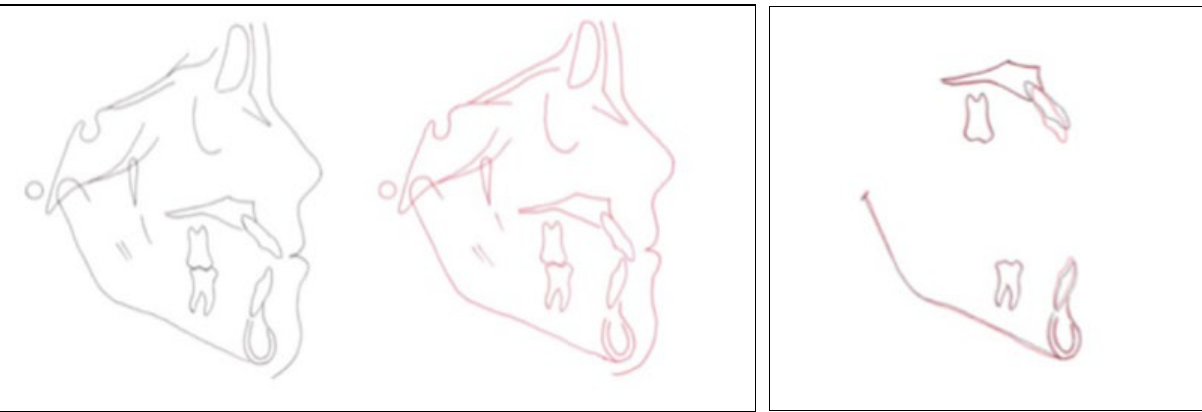
Figure 10. Lateral cephalogram pre-surgery (left) and post-treatment (right). Figure 11. Superimposition of the maxilla and mandible: pre-surgery (black) and post-treatment